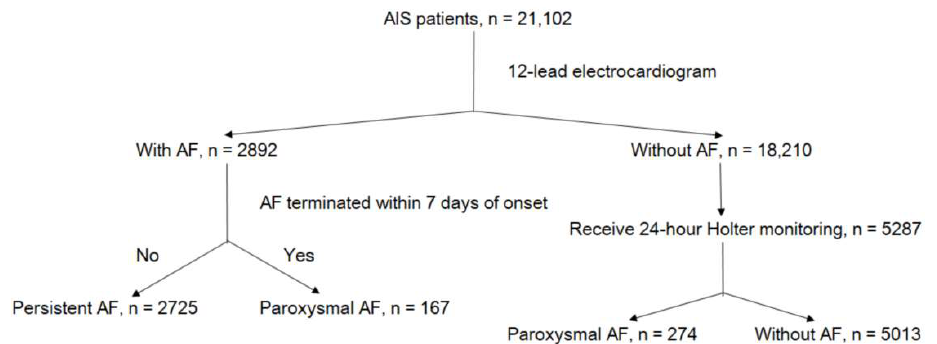
Figure 1. Flowchart of patient selection. Abbreviations: AIS, acute ischemic stroke; AF, atrial fibril- lation.